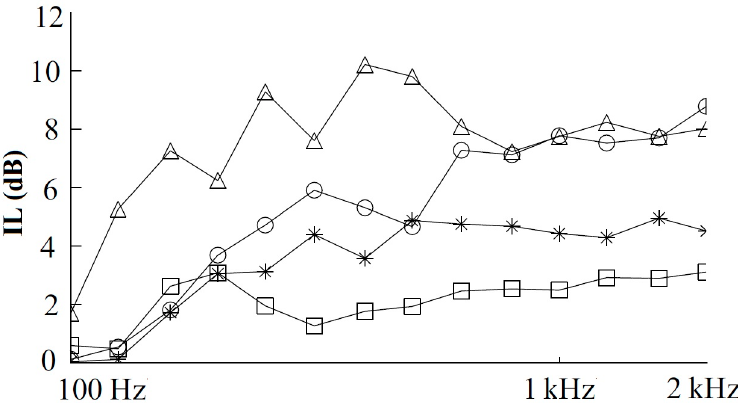
Figure 4. IL for various sonic crystals design. ✲ D = 0.15 m and ff = 1; ◻ D = 0.30 m and ff = 0.225; O D = 0.15 m and ff = 2; △ D = 0.30 m and ff = 1, modified from [36].